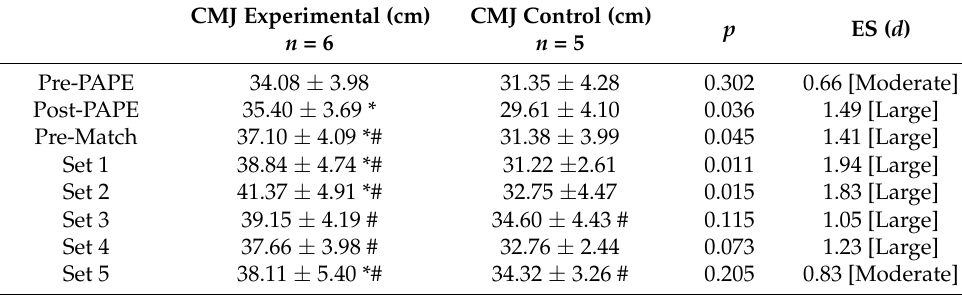
Table 2. Vertical jump height performance (mean ± SD).